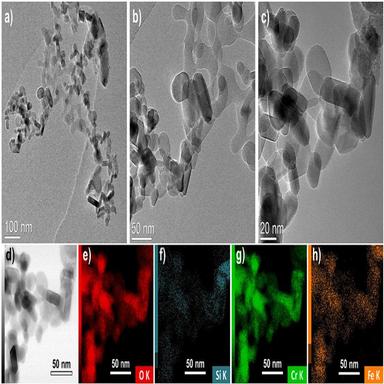
a–c) TEM images of ODND at different magnifications. d) corresponding bright-field STEM image of c). e–h) EDX spectroscopy elemental mapping of O-, Si-, Cr- and Fe K-edges, respectively.